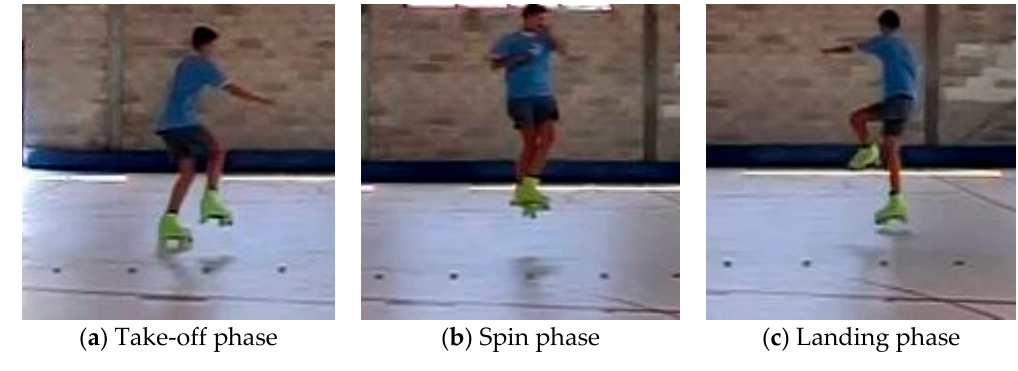
Figure 2. Double Salchow sequences.